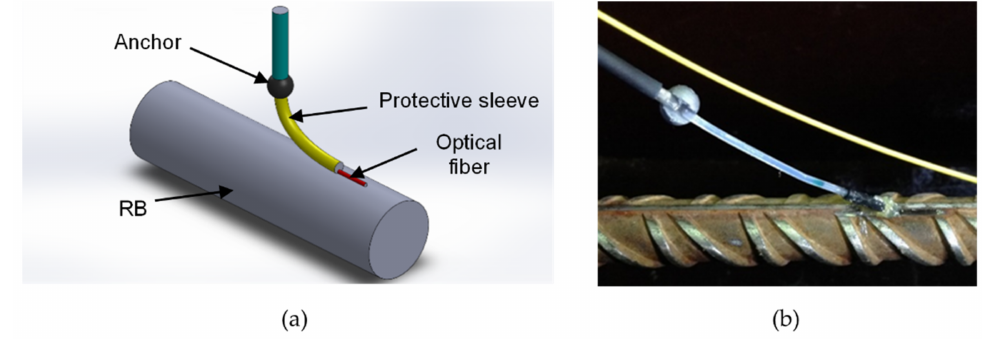
Figure 1. Details of the bond-slip sensor: ( a ) Sketch of the sensor. ( b ) Final aspect of the sensor attached to the